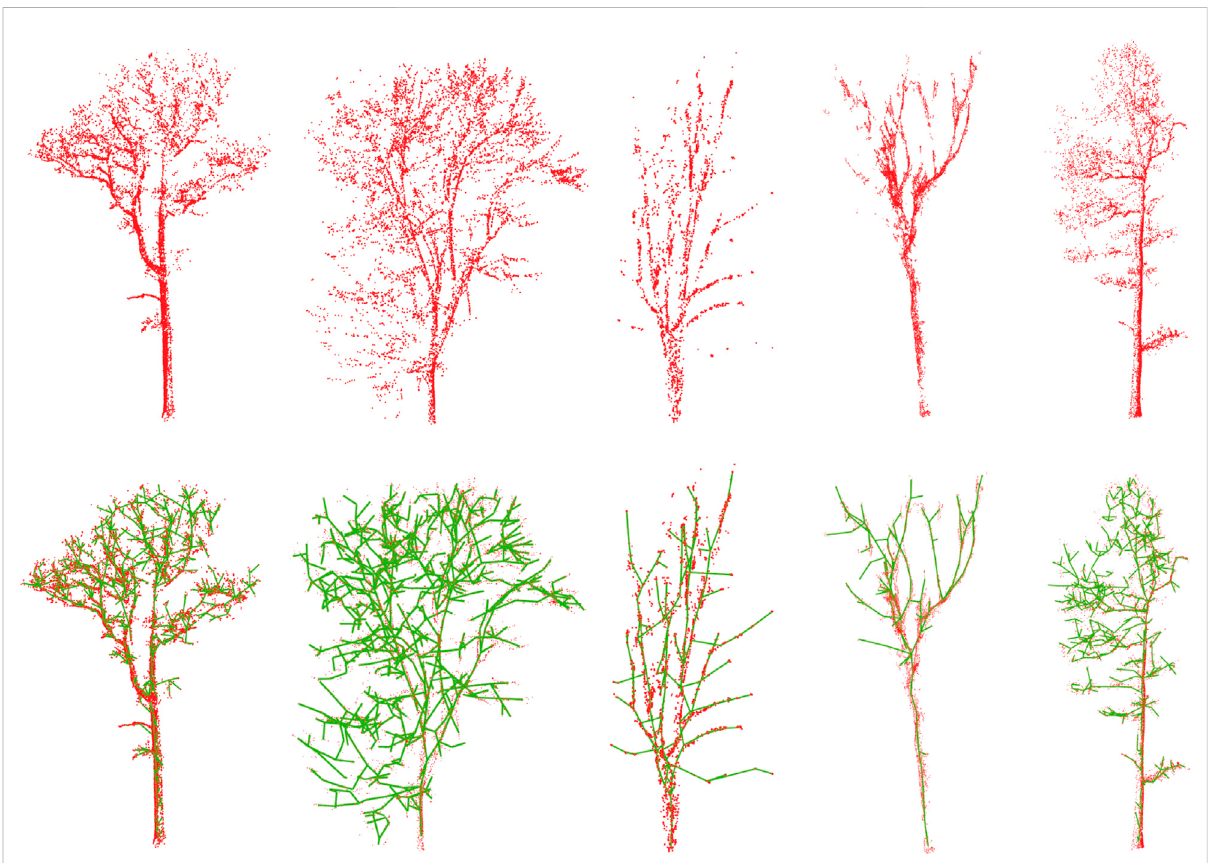
FIGURE 9 Ourresultsforthe3Dreconstruction oftreeskeletonsfromscanneddata.Asetof fi verealtreespecimensthatweremodeledfromUAV-LiDAR sensors has been